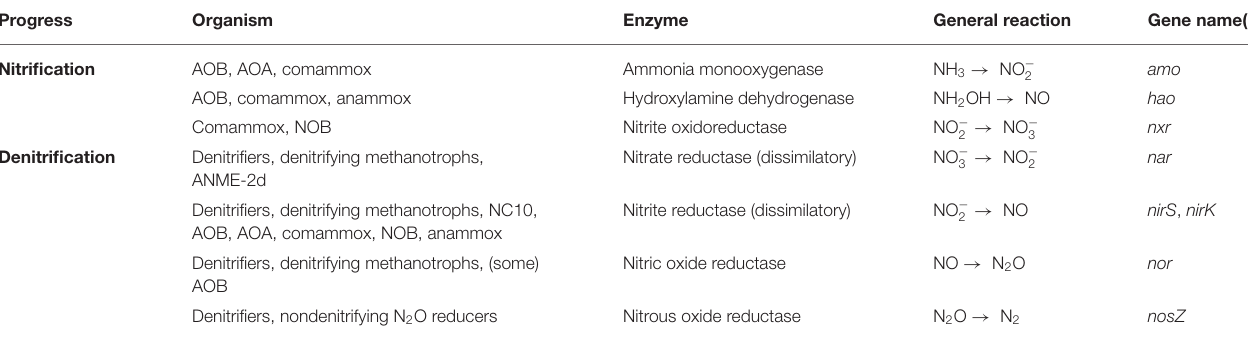
TABLE 1 | Enzymes and functional genes involved in microbial production and consumption of N 2 O. Progress Organism Enzyme General